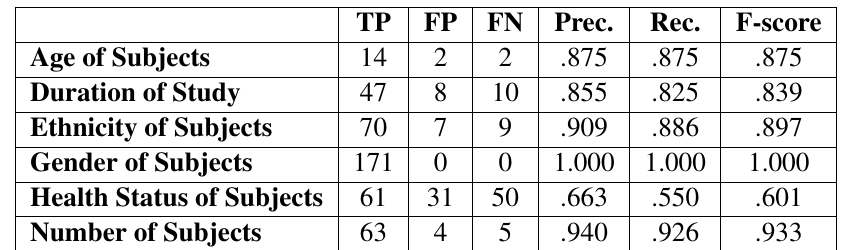
Table 2: Test set exact match statistics